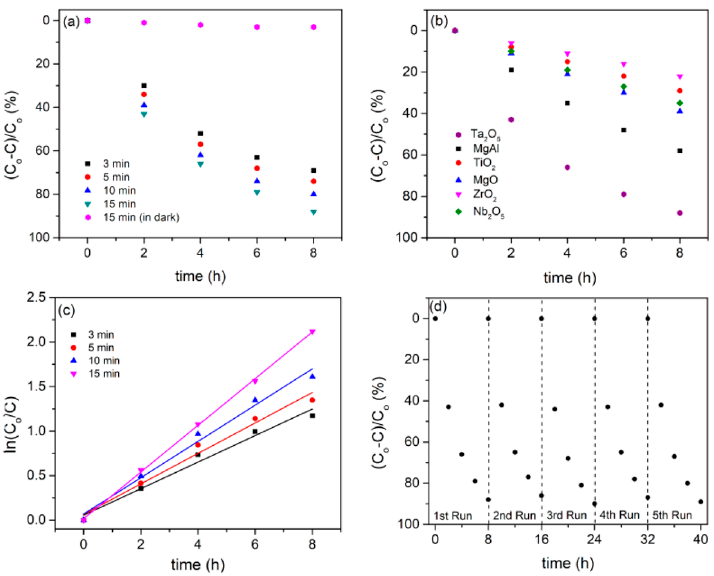
Figure 7. ( a ) PA of Ta 2 O 5 coatings formed at various stages of the MDs; ( b ) PA for different coatings formed by MDs process; ( c ) First-order kinetic plots of Ta 2 O 5 coatings formed at various stages of the MDs; ( d ) Recycling test of MO photodegradation of coating formed for 15 min.